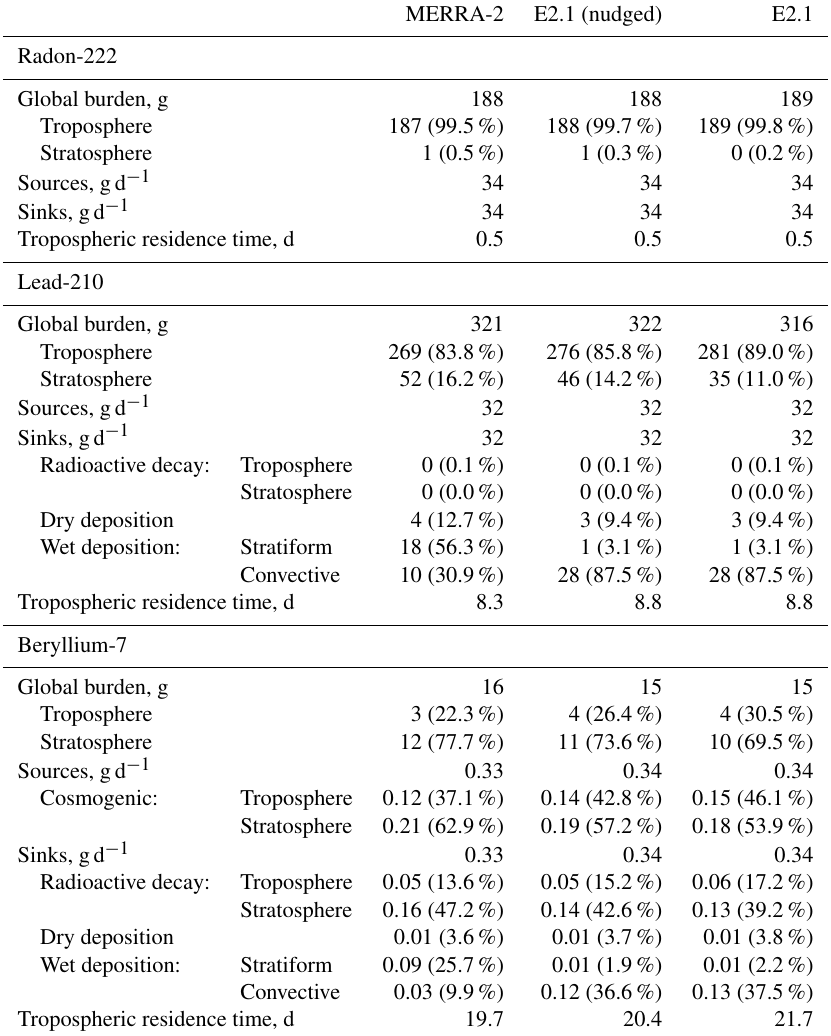
Table 4. Radionuclide budgets for